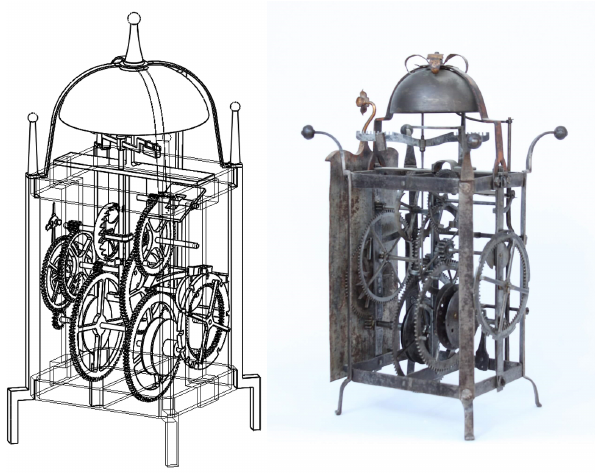
Figure 15. N5 – South-German iron chamber clock (Gude & Meis,